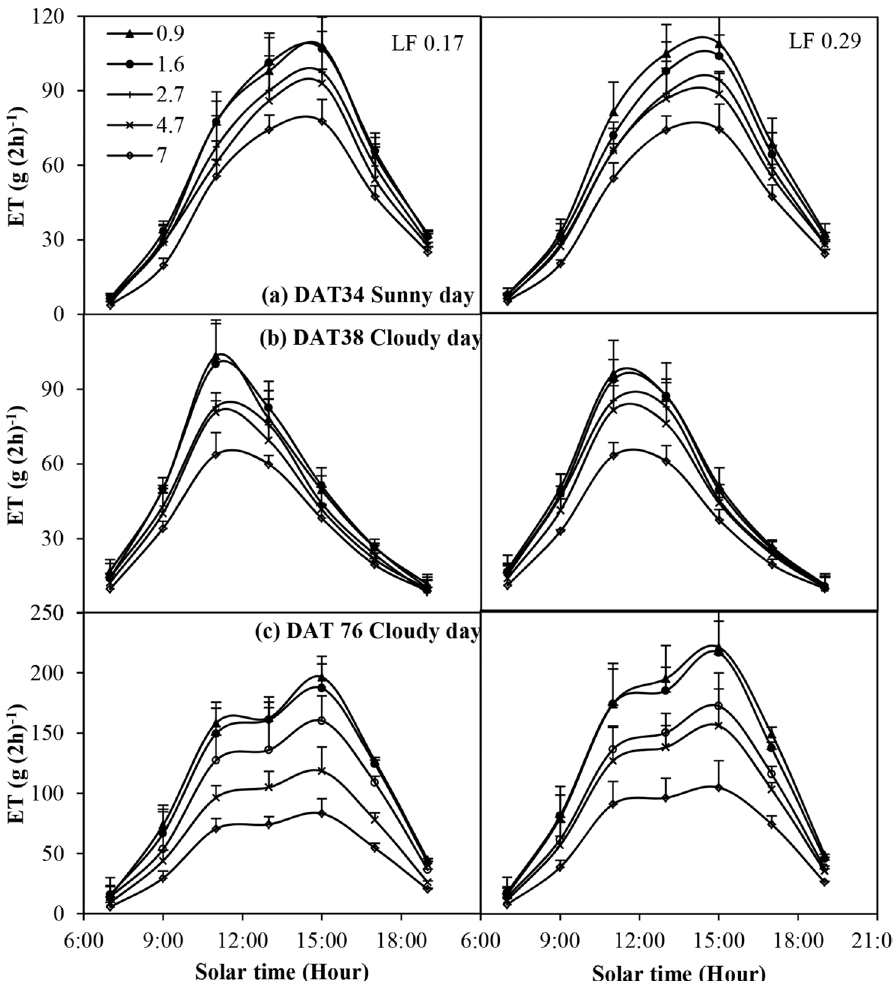
Figure 2. Diurnal variation of evapotranspiration (ET) under various irrigation water salinity levels and leaching fractions (LF). The error bars indicate standard deviation of ET. DAT represents days after